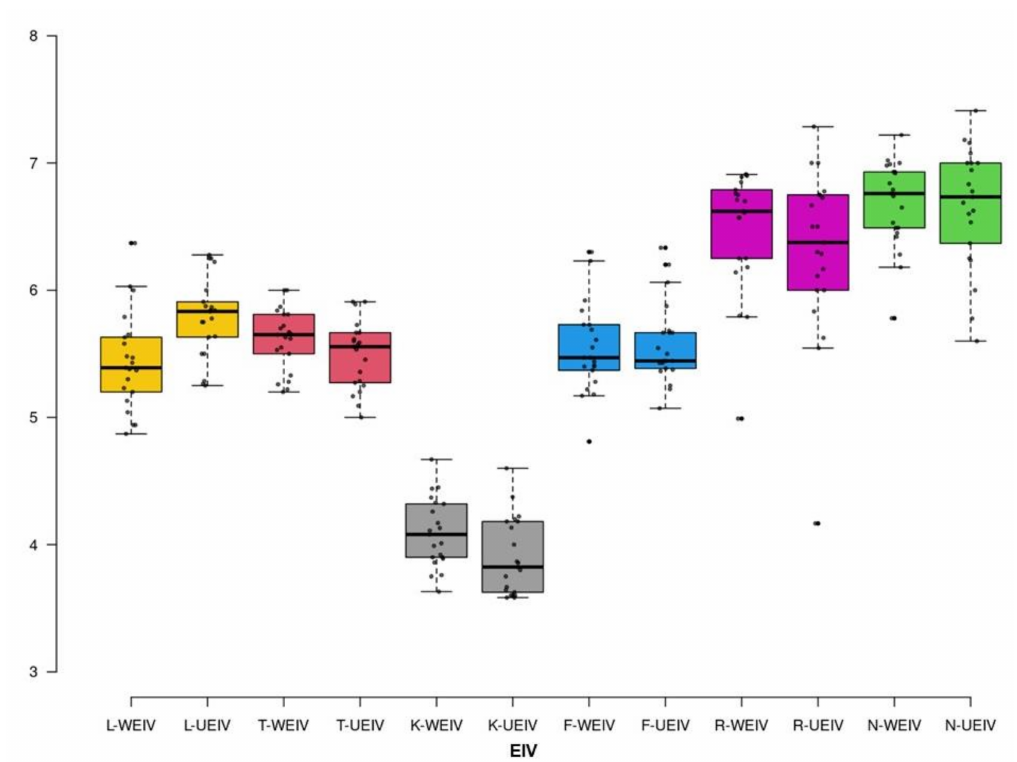
Figure 7. The medians of weighted (WEIV) and unweighted Ellenberg indicatory values (UEIV) for sites with small balsam ( Impatiens parviflora ) (L-WEIV, L-UEIV—light, T-WEIV, T-UEIV—temperature, K-WEIV, K-UEIV—continentality, F-WEIV, F-UEIV—soil moisture, R-WEIV, R-UEIV—soil pH, N- WEIV, N-UEIV—soil nutrients). NSp-76. Value for each population is indicated by